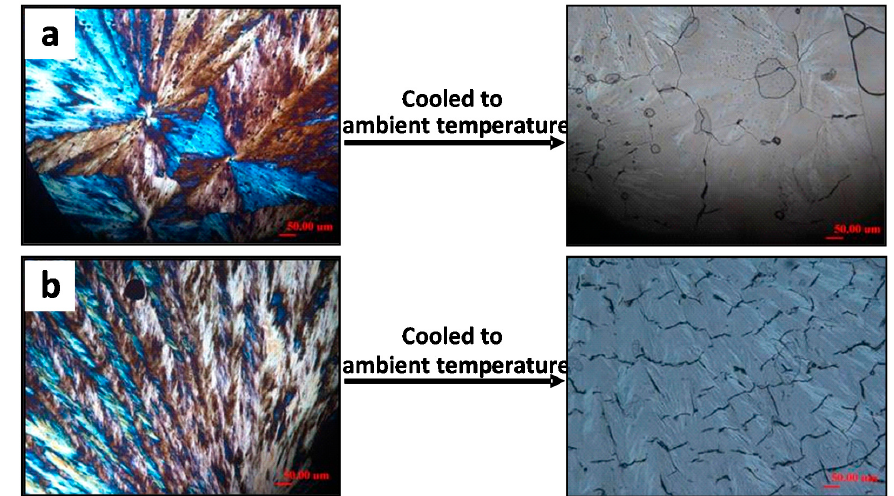
Figure 13. Irregular tangential cracks and ringless spherulites as revealed in POM ( left column) and OM ( right column) for LM w -PLLA-11k isothermally crystallized at 130 °C: ( a ) glass substrate untreated but glass cover pre-treated with release agent; and ( b ) both glass substrate and cover treated with release agent (scale bar = 50 μ m in all graphs).